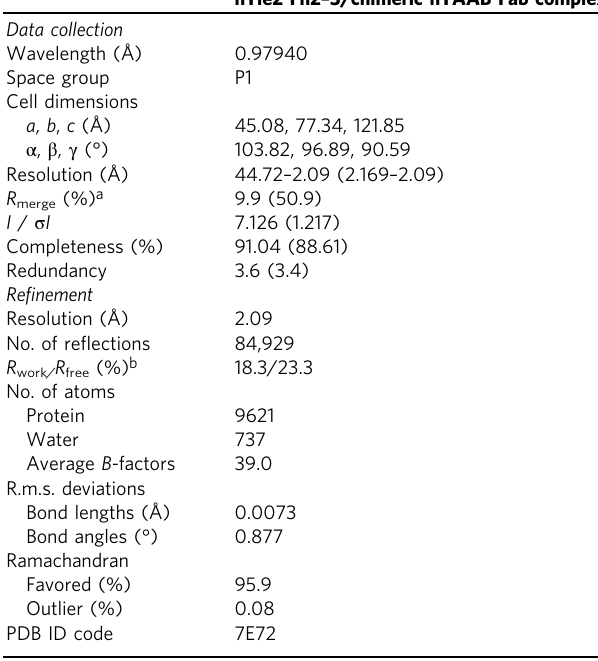
Table 1 Data collection and re fi nement